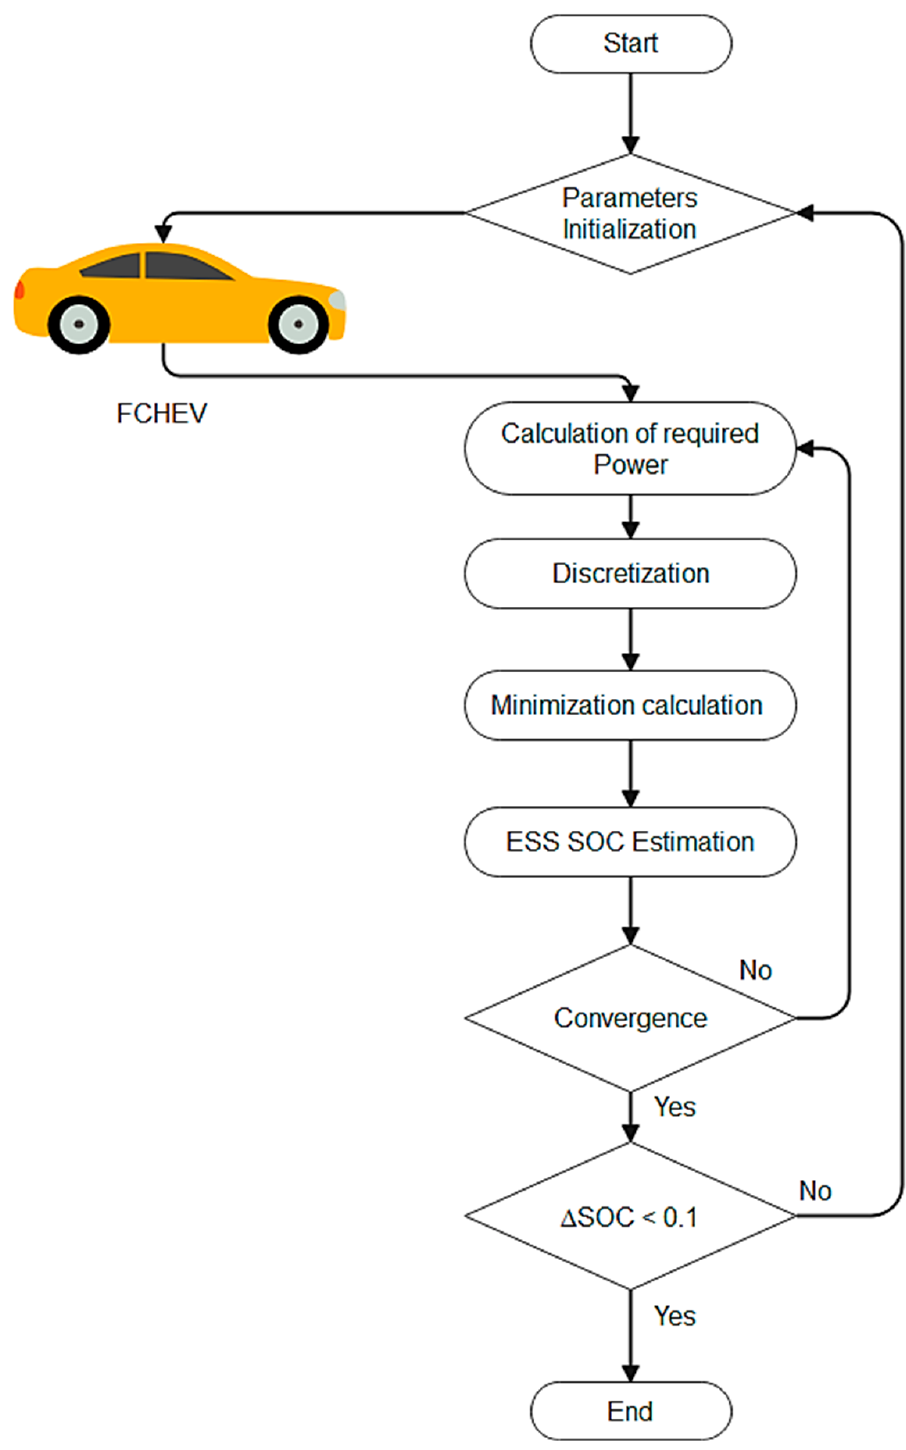
Figure 8. PMP fl owchart. Figure 8. PMP Table 5. Summary of the latest literature related to PMP-based EMS.